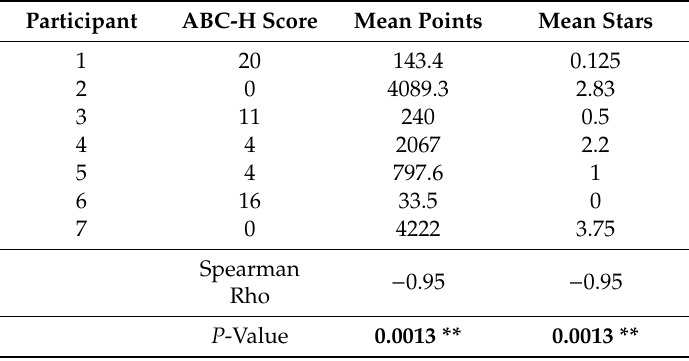
Table 2. Mean Participant ABC-H Score vs In-game Performance (Points & Stars Rewards).